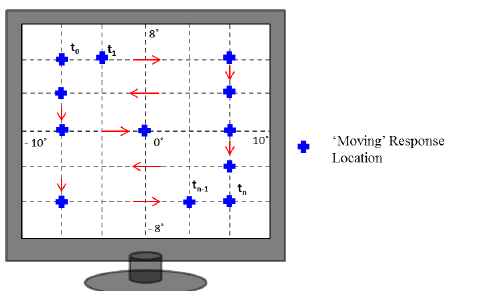
Figure 10: Displaying of one response location on the screen changing with time.